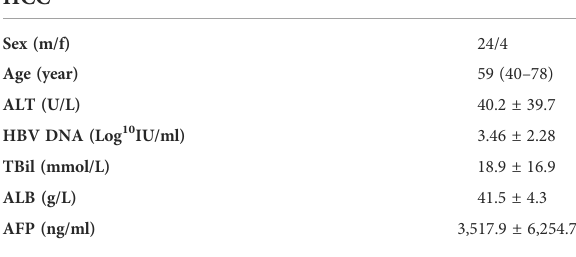
TABLE 1 Baselines of patients with hepatocellular